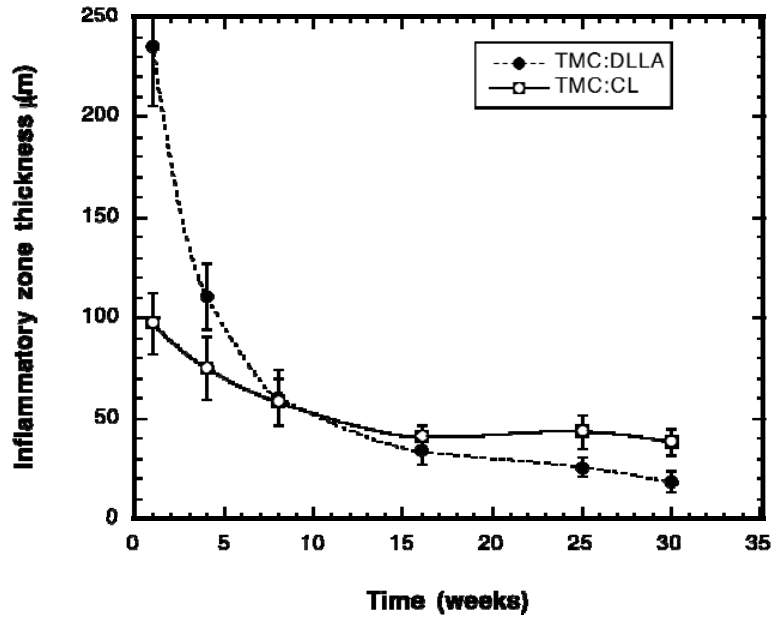
Figure 7. Change in the thickness of the zone of inflammation surrounding the implanted elastomer cylinders with respect to time of